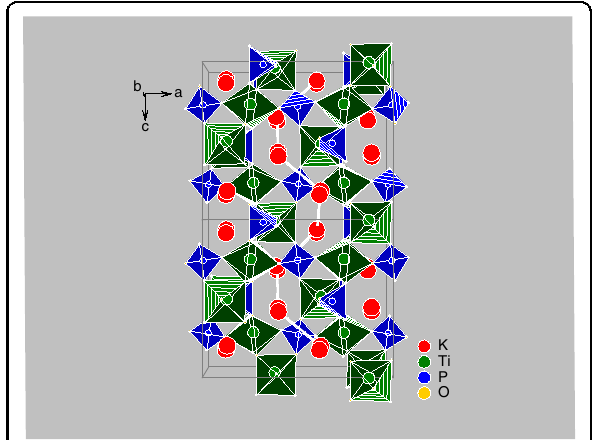
Fig. 2 Structure and quasi-one-dimensional ionic conductivity of KTP. Structure of KTP, Ball-polyhedral representation of the KTP crystal structure with split K sites, showing continuous channels along the [001]